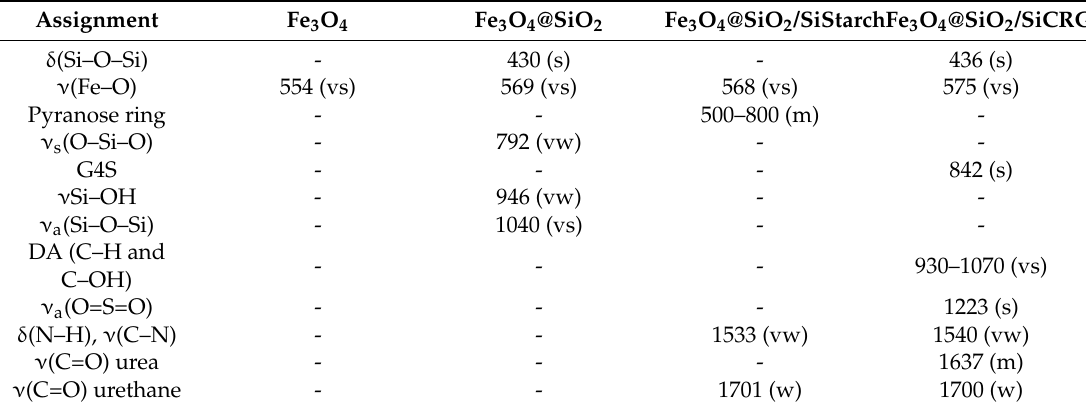
Table 2. Selected vibrational bands of the materials investigated in this